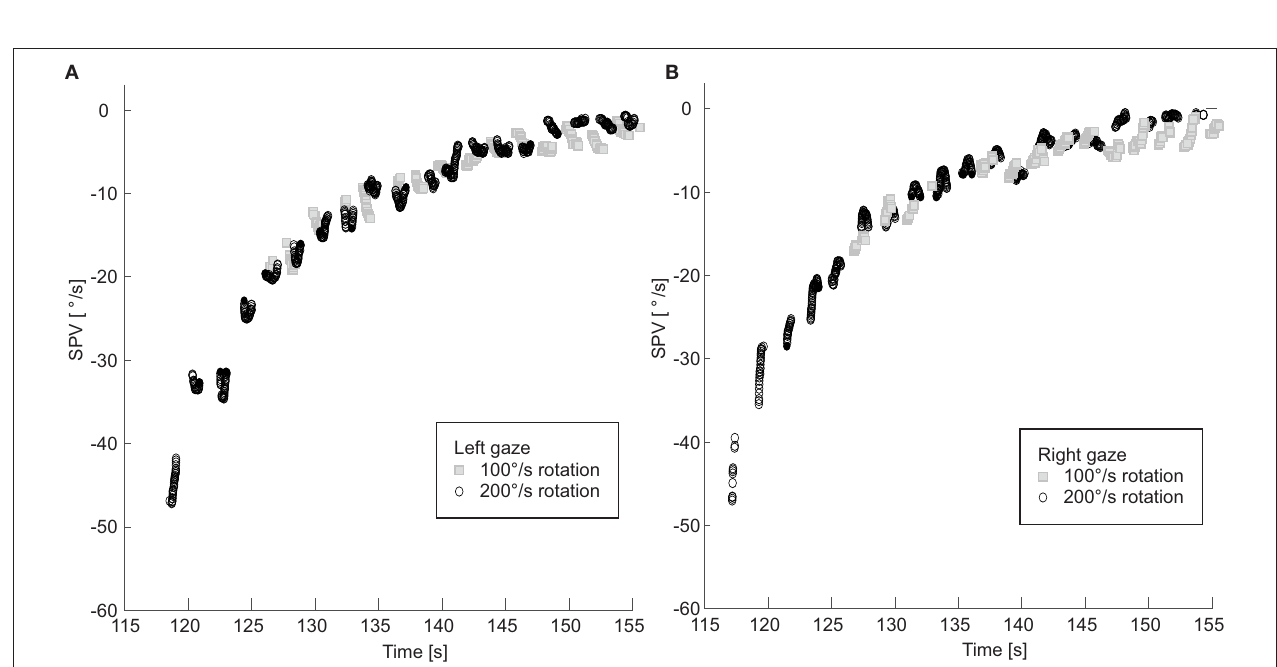
FIGURE 4 | SPV is shown for rotations at 100 and 200 ◦ /s with right (A) and left (B) gaze. Note the two right and left SPV curves still overlap even when the initial slow phase velocities are different.